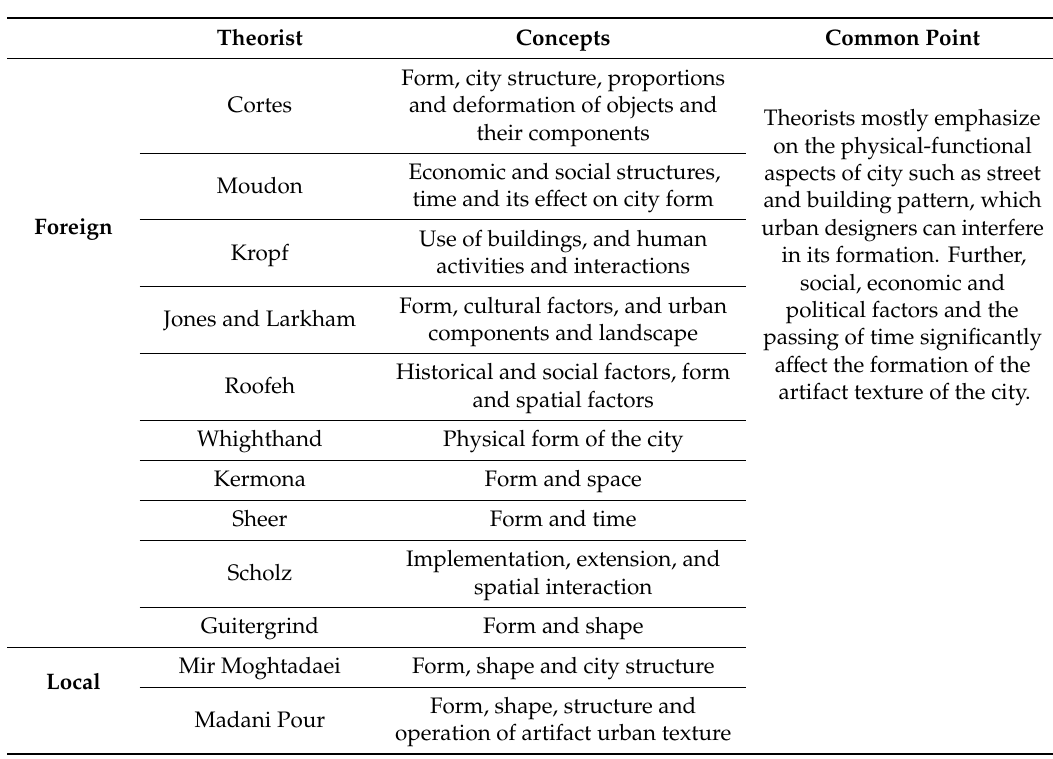
Table 1. Conceptual dimensions of morphology according to di ff erent